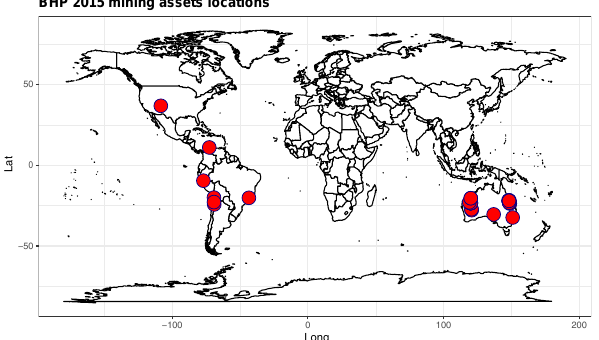
Figure A1. Map of BHP Billiton 2015 mining assets.